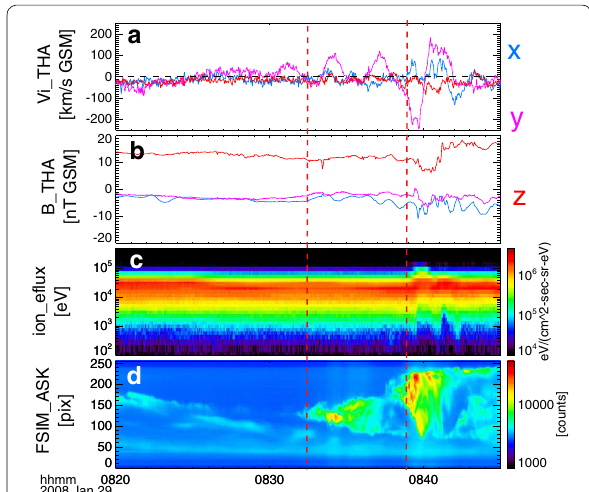
Fig. 2 Overview of THEMIS-A measurements between 08:20 UT and 08:50 UT. a Ion bulk flow components in GSM coordinates, b vector magnetic field components in GSM coordinates, c ion differential energy flux, and d auroral keogram of FSIM station. The two dashed vertical red lines indicate two auroral intensifications